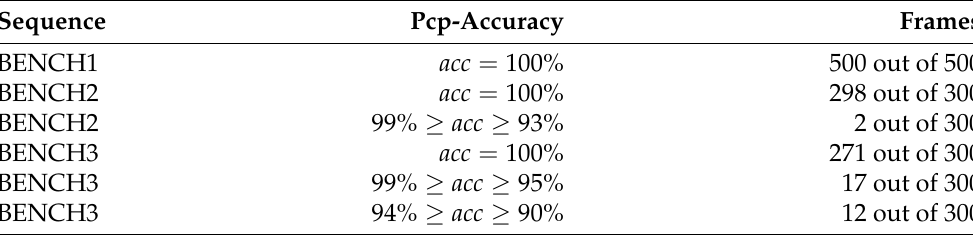
Table 2. Accuracies of parent–children pairing algorithm. We applied our parent–children pairing algorithm to three long synthetic image sequences BENCH1 (500 frames), BENCH2 (300 frames), and BENCH3 (300 frames), with interframe intervals of 1, 2, 3 min, respectively. The table summarizes the resulting pcp-accuracies. Note that pcp-accuracies are practically always at 100%. For BENCH2, pcp-accuracies are 100% for 298 frames out of 300, and for the remaining two frames, accuracies were still high at 93% and 96%. For BENCH3, the average pcp-accuracy for the 3 min interframe is 99%. Sequence Pcp-Accuracy Frames BENCH1 acc = 100% 500 out of 500 BENCH2 acc = 100% 298 out of 300 acc 99% 93% 2 out of ≥ ≥